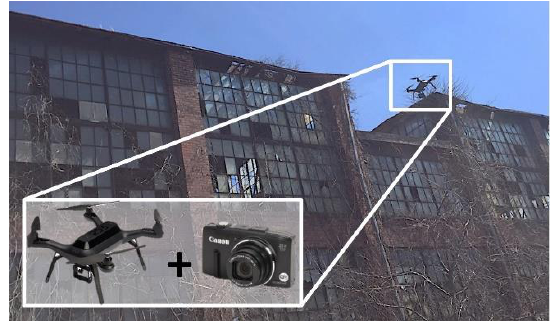
Figure 5. Image collection using an unmanned aerial vehicles (UAV) (3DR Solo Quadcopter) with a consumer-grade camera (Canon PowerShot SX280). consumer-grade camera (Canon PowerShot